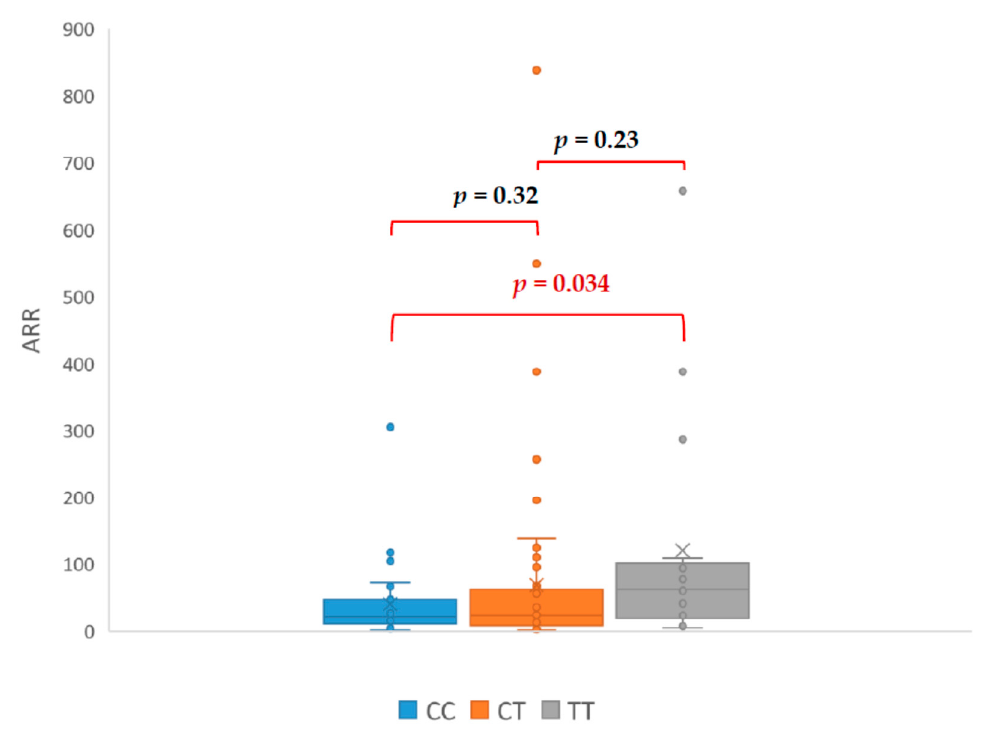
Figure 2. Di ff erences in aldosterone-renin ratio (ARR—aldosterone-renin Figure 2. Differences in aldosterone-renin ratio (ARR—aldosterone-renin ratio).